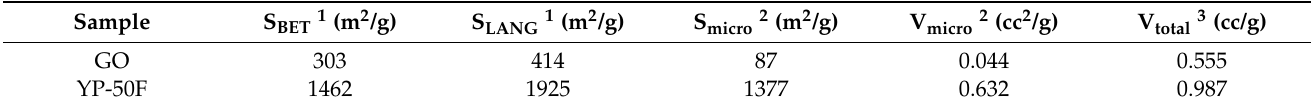
Table 1. Surface areas and pore volumes of (graphene oxide) GO and (activated carbon) YP-50F determined by N 2 physisorption at 77K.